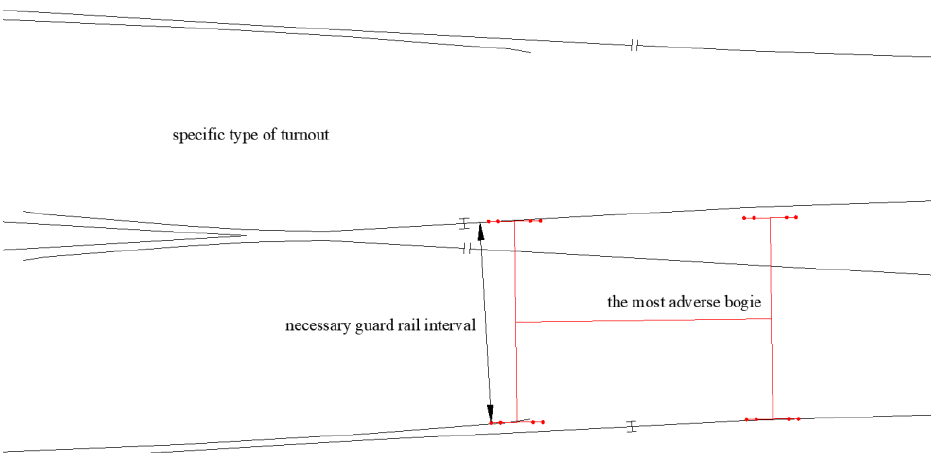
Figure 9. Calculation method of the guardrail interval limit based on the vehicle running attitude.